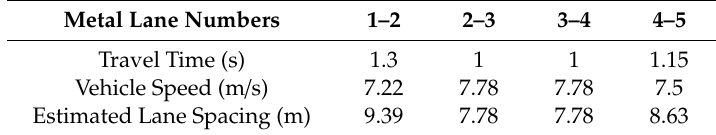
Figure 11. Energy detector output for Scenario 4. Table 3. Metal lane spacing estimation for Scenario 4.